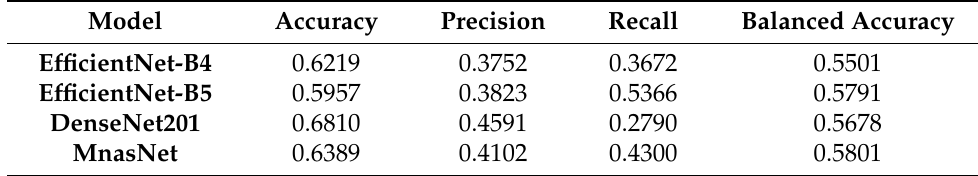
Table 8. The performance of the diffuse glioma grading